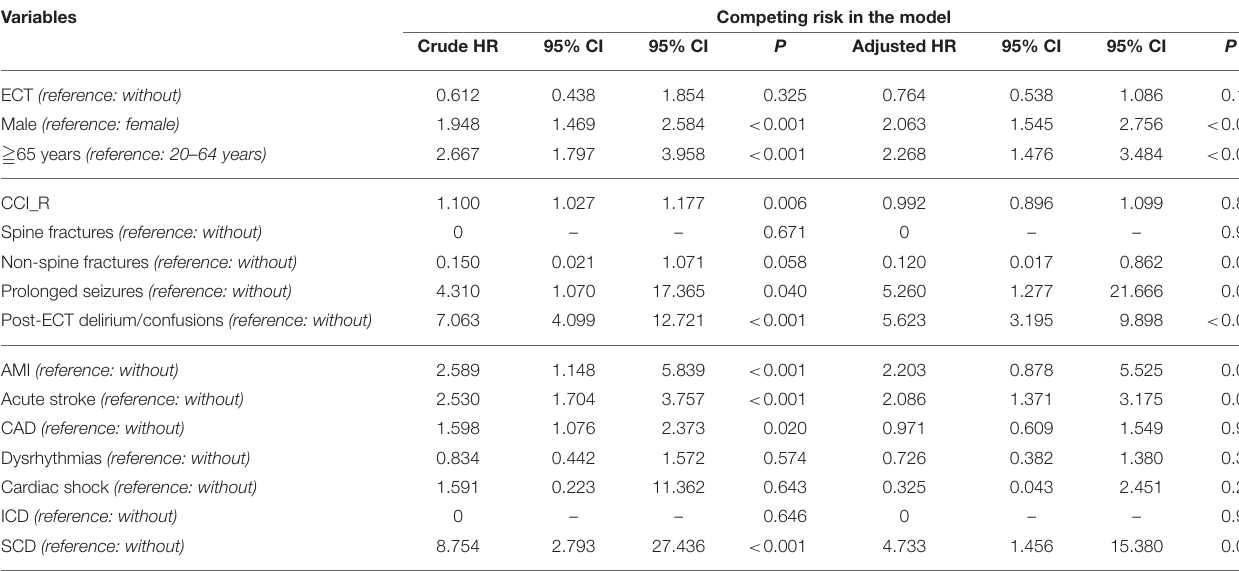
TABLE 3 | Factors of dementia by using Fine and Gray’s competing risk model.